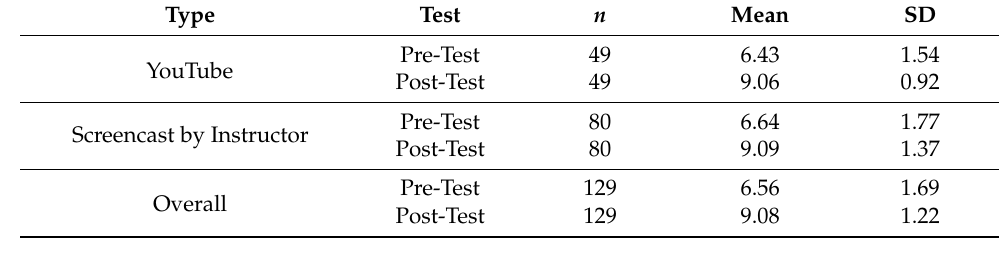
Table 1. Descriptive statistics of the pre and post-tests in both groups.